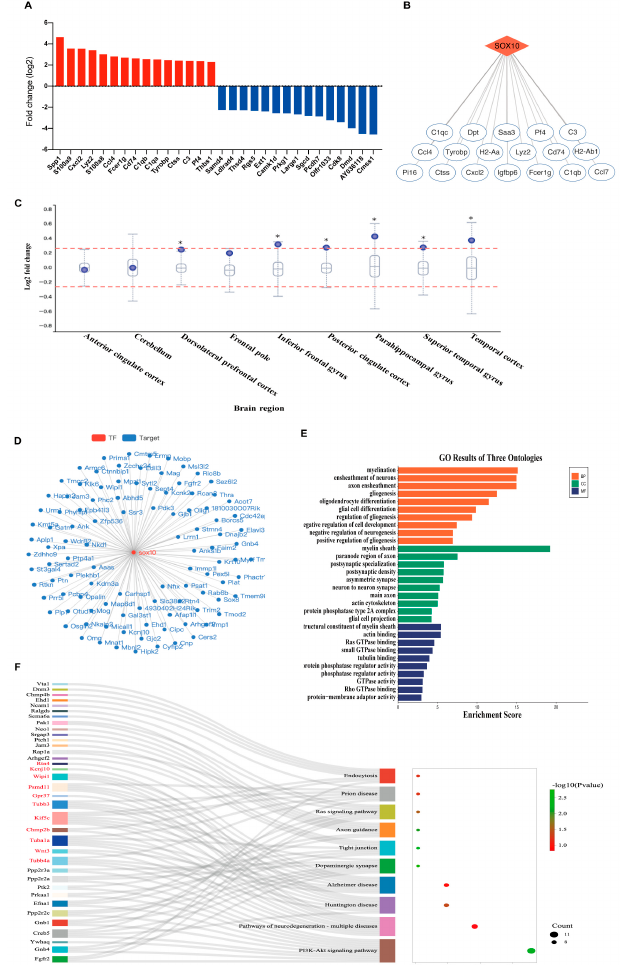
Figure 5. Sox10 is closely associated with neurodegenerative diseases. ( A ) Top differentially expressed genes in modulated VSMCs of the neointima of those mice with ligated carotid arteries from single- cell RNA sequencing ( n = 30 mice). ( B ) Potential transcriptional regulatory target genes of Sox10 in modulated VSMCs. ( C ) Differential expression of Sox10 between AD cases and controls across brain regions from the AMP-AD knowledge portal. The box plot depicts how the differential expression of Sox10 (purple dot) compares to the expression of other genes in a given tissue. Meaningful differential expression is considered to be a log2 fold change value greater than 0.263 or less than –0.263 (red line). ( D ) The interaction network of transcription factor Sox10 and its downstream target genes detected in the mouse brain using the GRNdb online network (http://www.grndb.com/; accessed on 6 November 2022). ( E ) Gene ontology (GO) terms of the Sox10 downstream target genes in the mouse brain. BP, biological process; CC, cellular component; MF, molecular function. ( F ) Sankey plot of the pathways enriched for the Sox10 downstream target genes in the mouse brain. Genes associated with neurodegenerative diseases are shown in